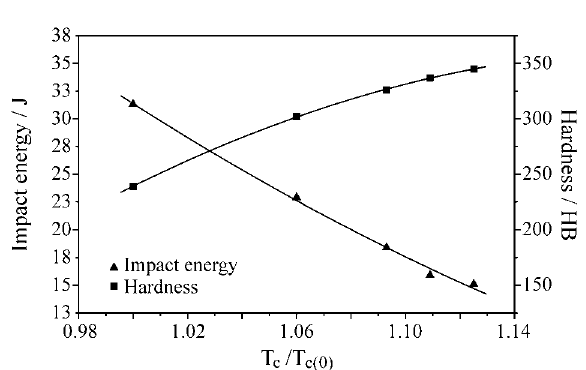
Figure 7. Mechanical properties (impact energy and Brinnel hardness) against T c